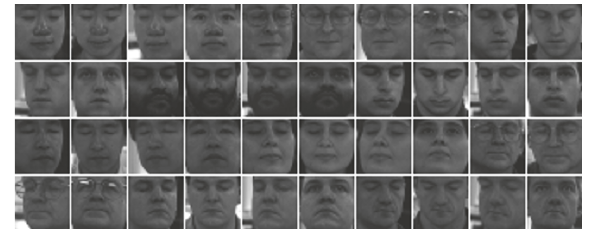
Figure 5: Examples of the CMU-PIE database.